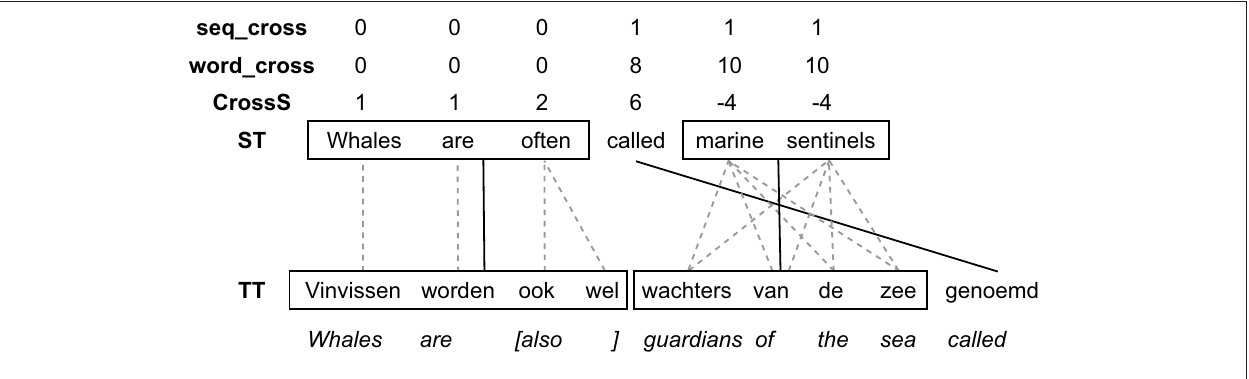
FIGURE 2 | A visualisation of Cross, word_cross and sequence cross in Example